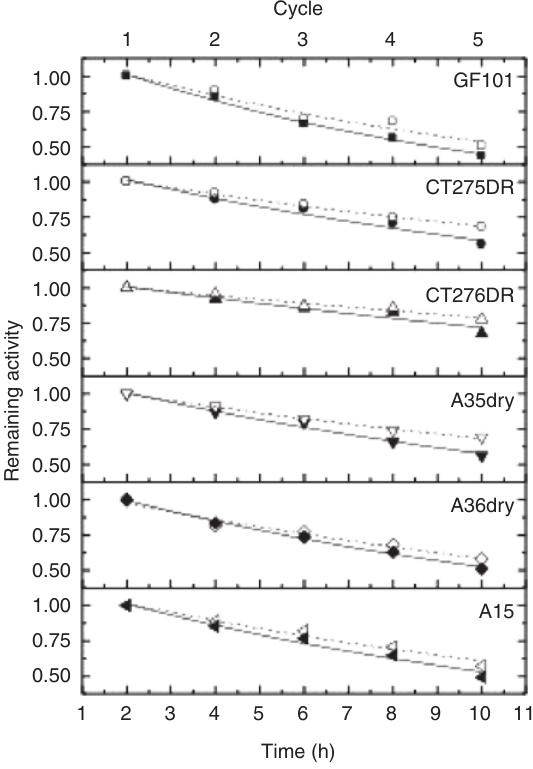
Figure 9: Progress of the experimental and fitted remaining activity with total operating time and number of recycles of the catalysts. Solid markers correspond to regenerated catalysts, open markers correspond to non-regenerated.